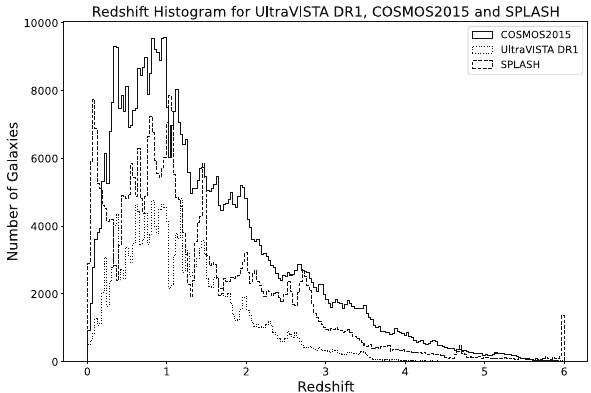
Fig. 1 Histogram showing the galaxy distribution numbers in terms of